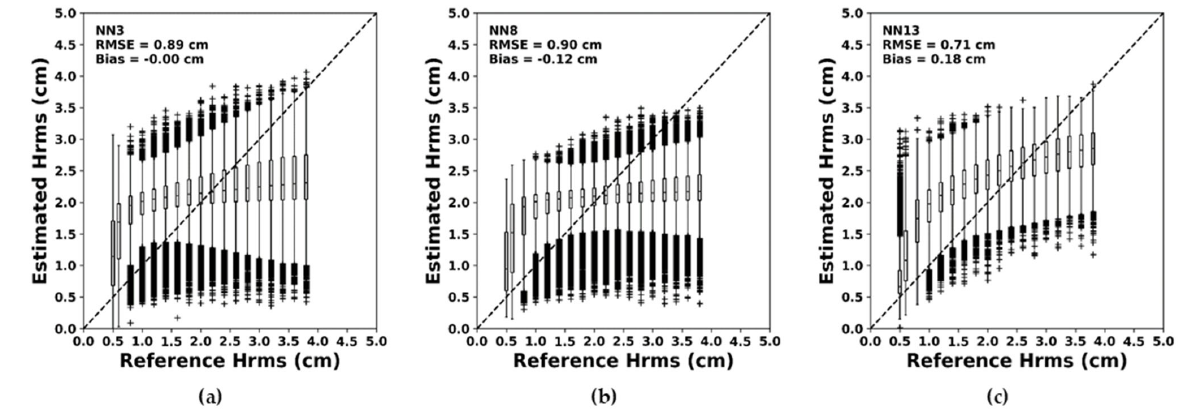
Figure 5. Estimated Hrms as a function of the reference Hrms using synthetic C ‐ band data: ( a ) NN without a priori information on SSM; ( b ) NN with a priori information on SSM in dry to slightly wet soil conditions; ( c ) NN with a priori information on SSM in very wet soil conditions. The non ‐ filled boxes represent the distribution of the estimation results at each class with the median line of the scores, and the plus signs represent the outliers of the estimations located outside the whiskers of the box plot.